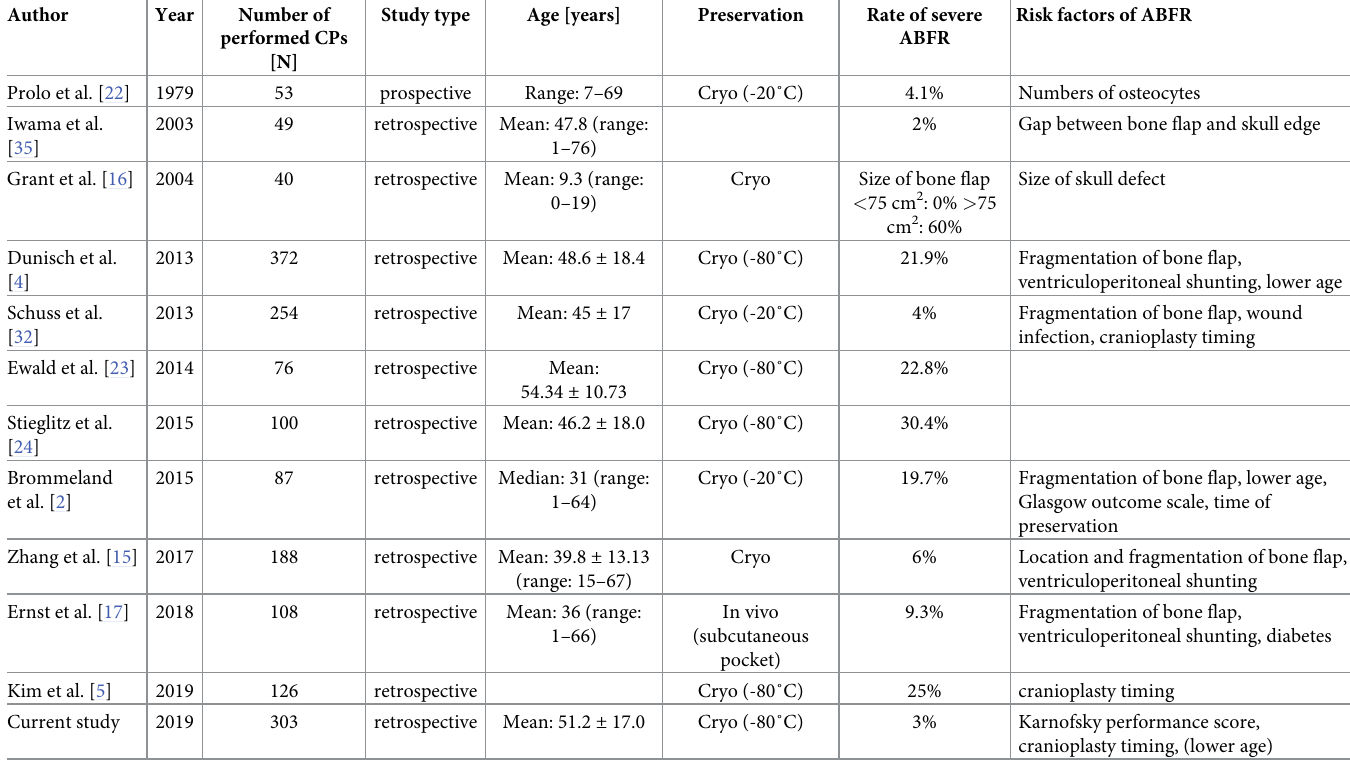
influencing factor. Interestingly, Brommeland et al. [2] found a high Glasgow outcome scale at Table 4. Review of risk factors leading to ABFR found in scientific